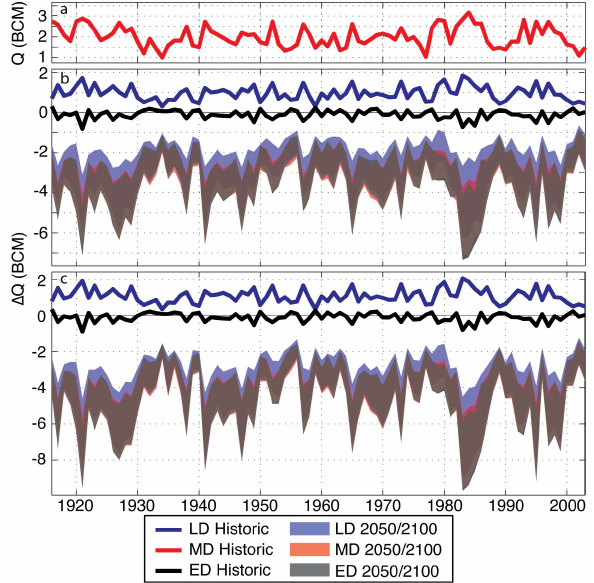
Fig. 9. (a) Annual total discharge at Lees Ferry under historic (cur- rent) climate and moderate dust deposition (MD) scenarios; (b) change in total annual discharge under lower dust (LD) and ex- treme dust (ED) loading scenarios, and for the decade centered on 2050; colored areas show the range between B1 and A2 emissions scenarios; (c) as in (b) , but for decade ending 2100. For climate change scenarios historic years represent interannual variability for the modeled period as described in the